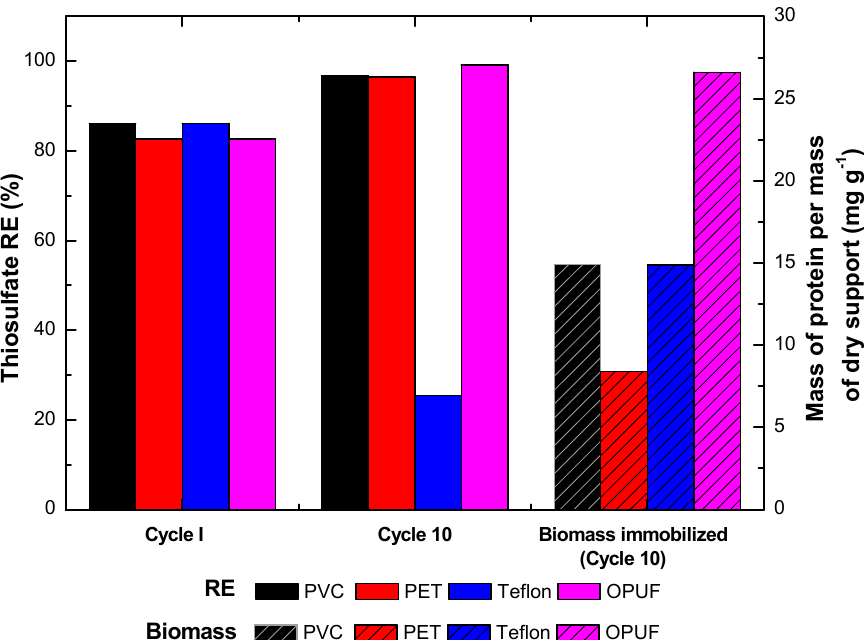
Figure 4. Thiosulfate Removal efficiency and biomass immobilized on the packing material after 10 cycles.